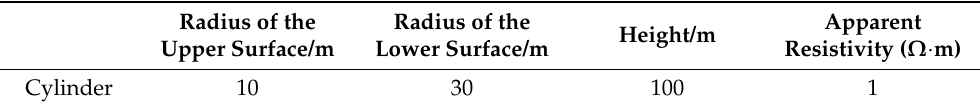
Table 2. Geoelectric parameters of the cylinder.